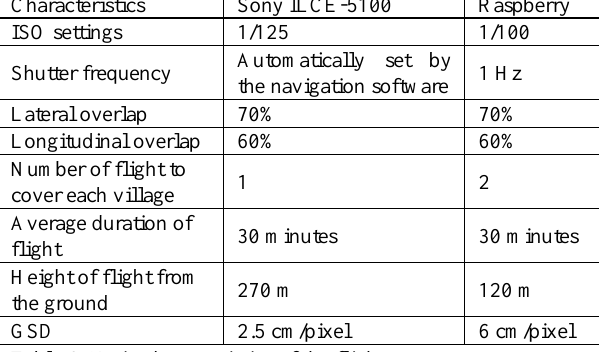
Table 6. Main characteristics of the flights.